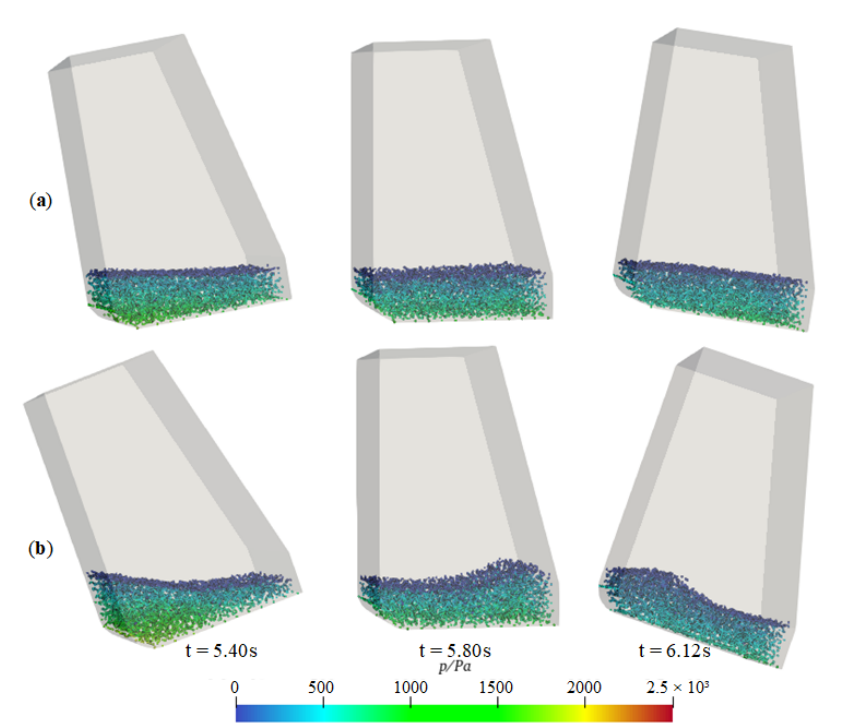
Figure 8. Snapshots of flow field at different rolling angles. ( a ) case 1; ( b ) case